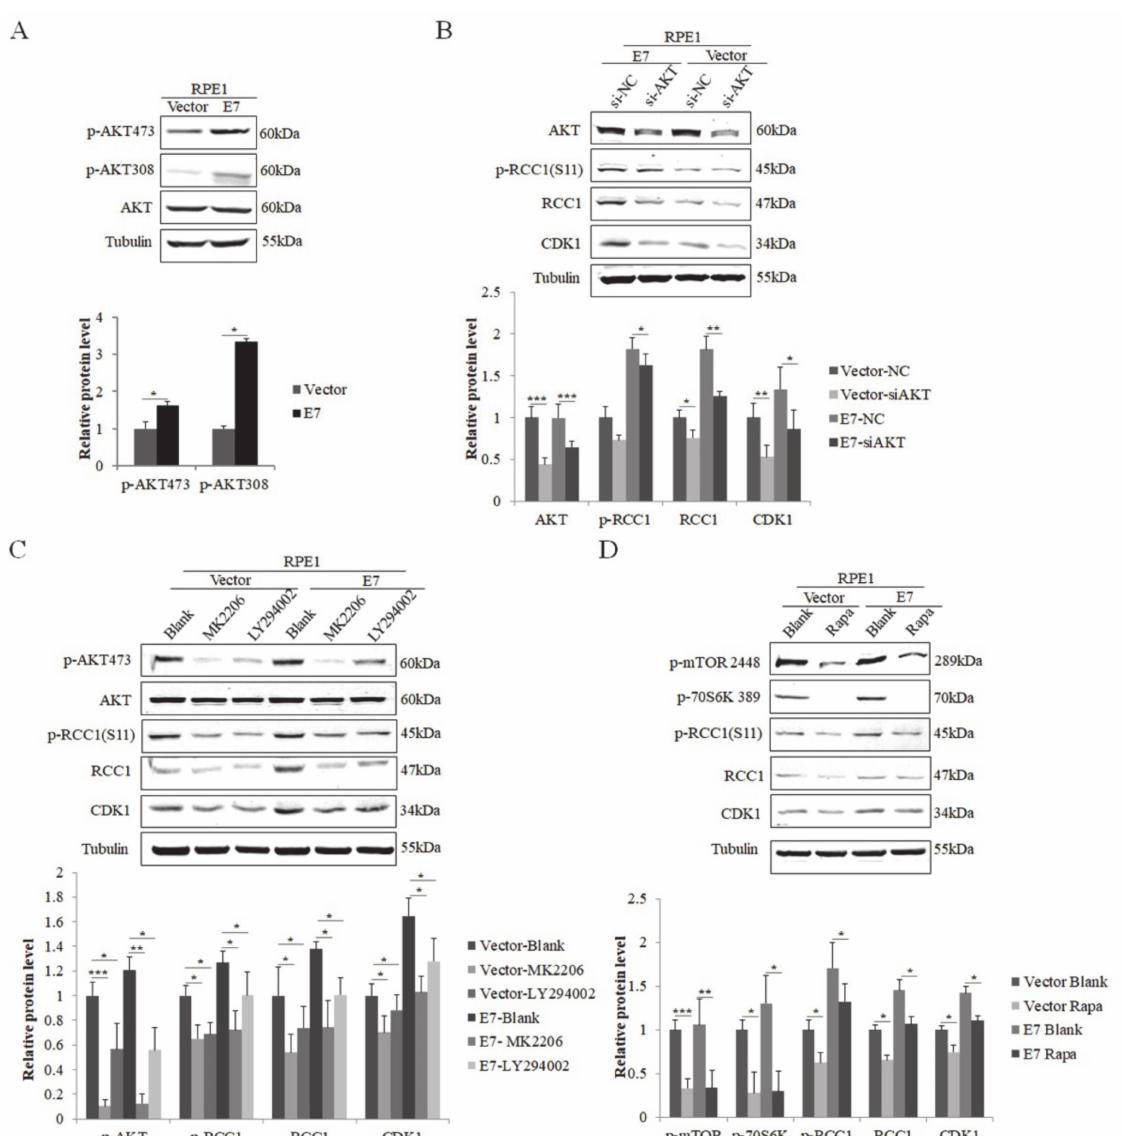
Figure 2. HPV E7 promoted phosphorylation of RCC1 S11 by the PI3K/AKT/mTOR pathway. ( A ) Upper panel: AKT and its phosphorylated forms were measured by Western blot. Lower panel: quantification of p-AKT 473 and p-AKT 308 proteins. ( B ) Western blot analysis of AKT, p-RCC1(S11), RCC1 and CDK1 in RPE1-E7 and control cells following AKT knockdown and quantification. ( C ) Protein levels of AKT, p-AKT 473, RCC1, p-RCC1(S11), CDK1 after treatment with MK2206 or LY294002 were detected by Western blot. ( D ) RPE1-E7 cells and control cells were treated with Rapa. As indicated, total protein lysates were analyzed for the expression of p-mTOR 2448, p-70S6K 389, p-RCC1(S11), RCC1, CDK1. Data shown are representative of 3 biological replicates. * p < 0.05; ** p < 0.01; *** p <